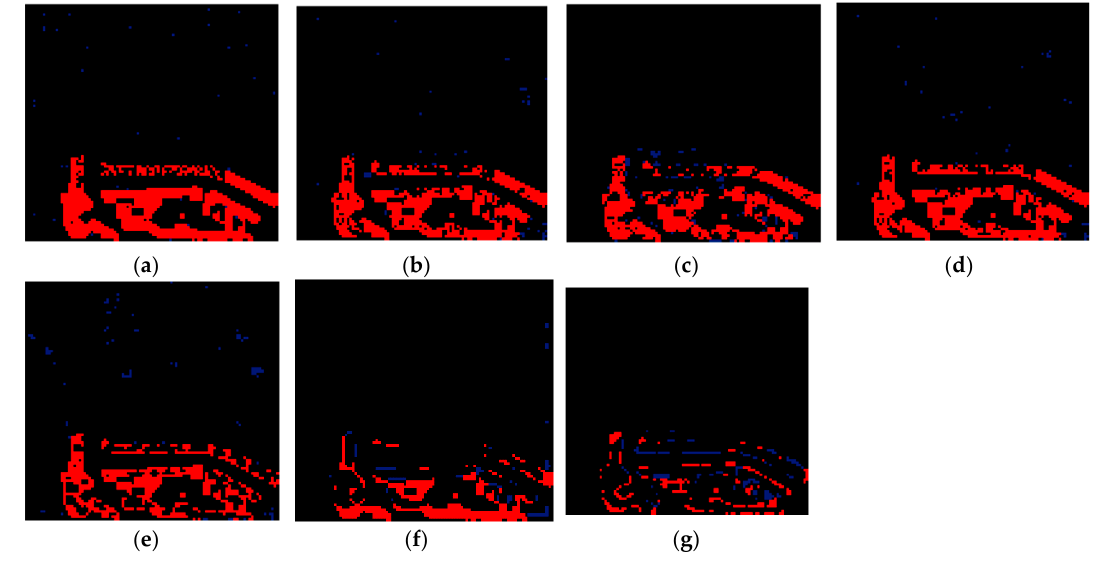
Figure 25. The errors in change detection using different methods for the PolSAR- Francisco2 dataset. ( a ) CVA-SVM, ( b ) MAD-SVM, ( c ) PCA-SVM, ( d ) IR-MAD -SVM, ( e ) SFA-SVM, ( f ) 3D-CNN, and ( g ) Proposed Method. Black, red, and blue colors indicate TP and TN, FN, and FP pixels, respectively.